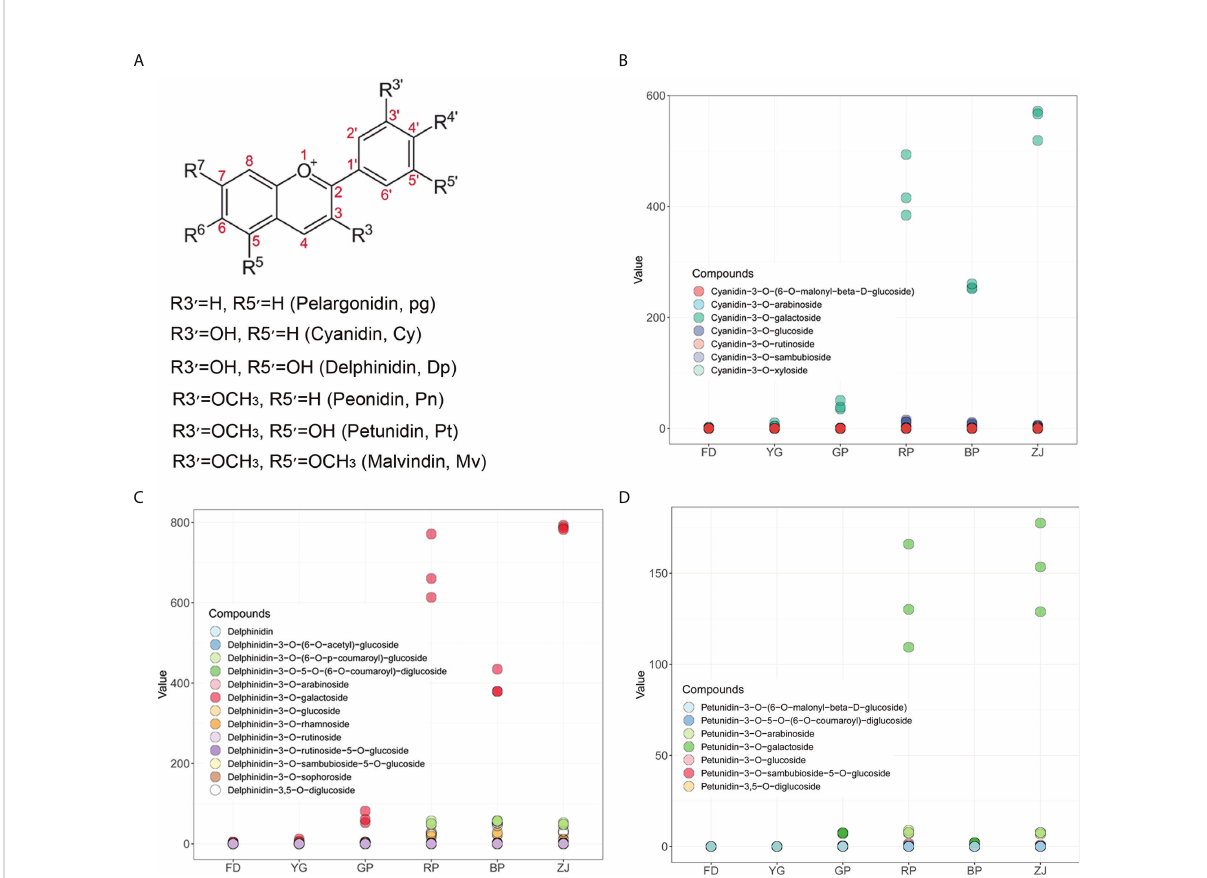
FIGURE 2 The main types of anthocyanins accumulation in C. sinensis . (A) The basic structure of anthocyanidins; (B) The accumulation variation of anthocyanins derived from Cy type in parents and F1 hybrid progenies; (C) The accumulation variation of anthocyanins derived from Dp type in parents and F1 hybrid progenies; (D) The accumulation variation of anthocyanins derived from Pt type in parents and F1 hybrid